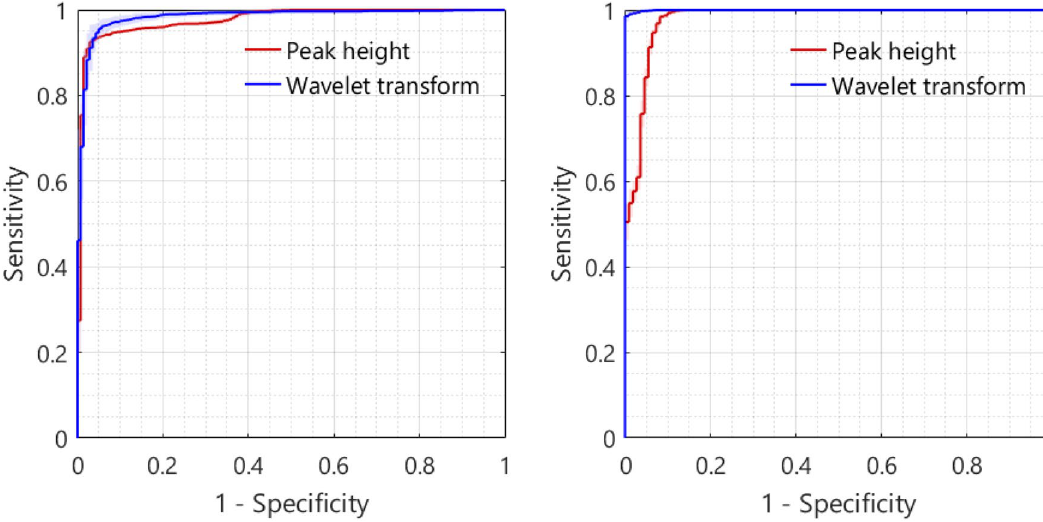
Figure 9. ROC curves of the tissue type classification for the first (left image) and second (right image) tissue layer, using the two feature extraction methods. The curves are averaged over the 20 iterations, the shaded area represents the standard deviation of the corresponding